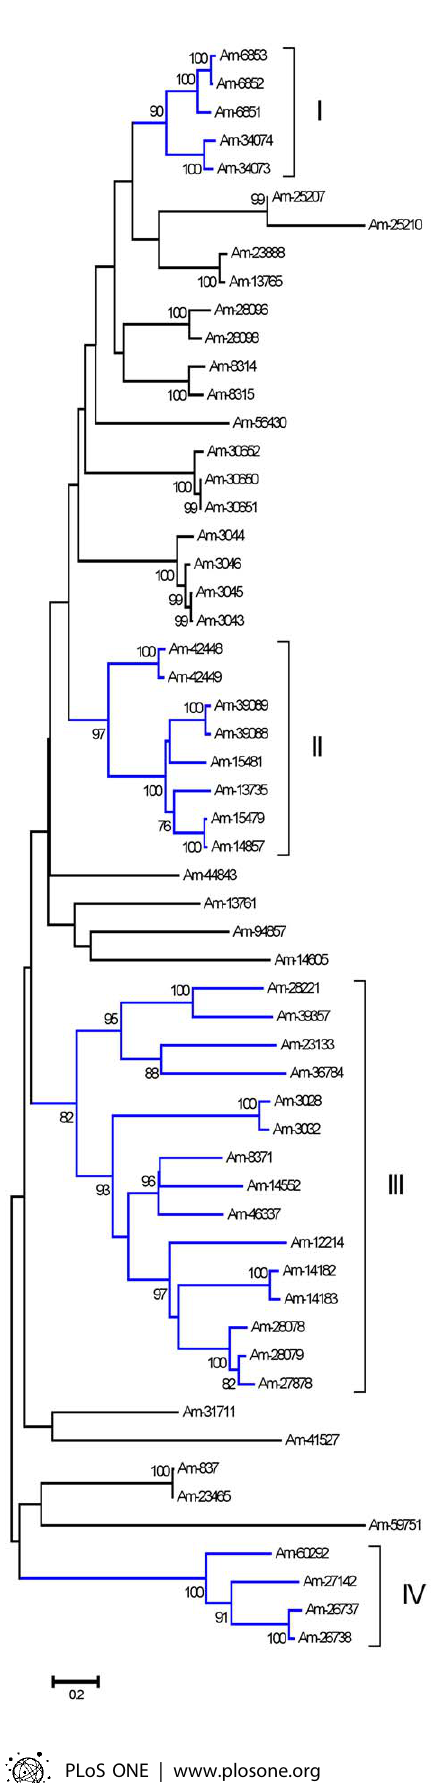
Figure 2. The salivary TIL domain family of proteins in Amblyommamaculatum . Bootstrapped phylogram (1,000 iterations) resulting from the alignment of 57 full-length protein sequences containing the Kunitz domain. The numbers on the nodes indicate the bootstrap support, and the bar at the bottom indicates 20% amino acid divergence. Clades with more than 80% bootstrap support are indicated by Roman numerals.